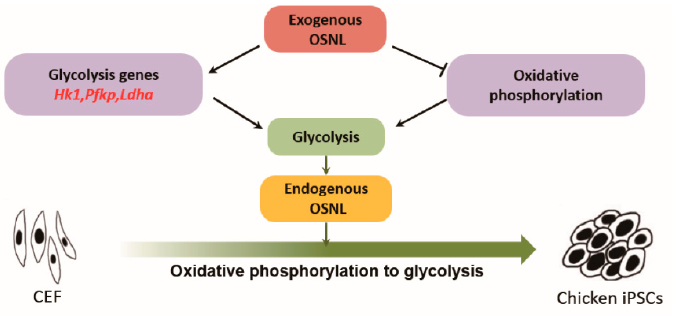
Figure 8. Schematic of function of 2i-SP during CEF reprogramming to chicken